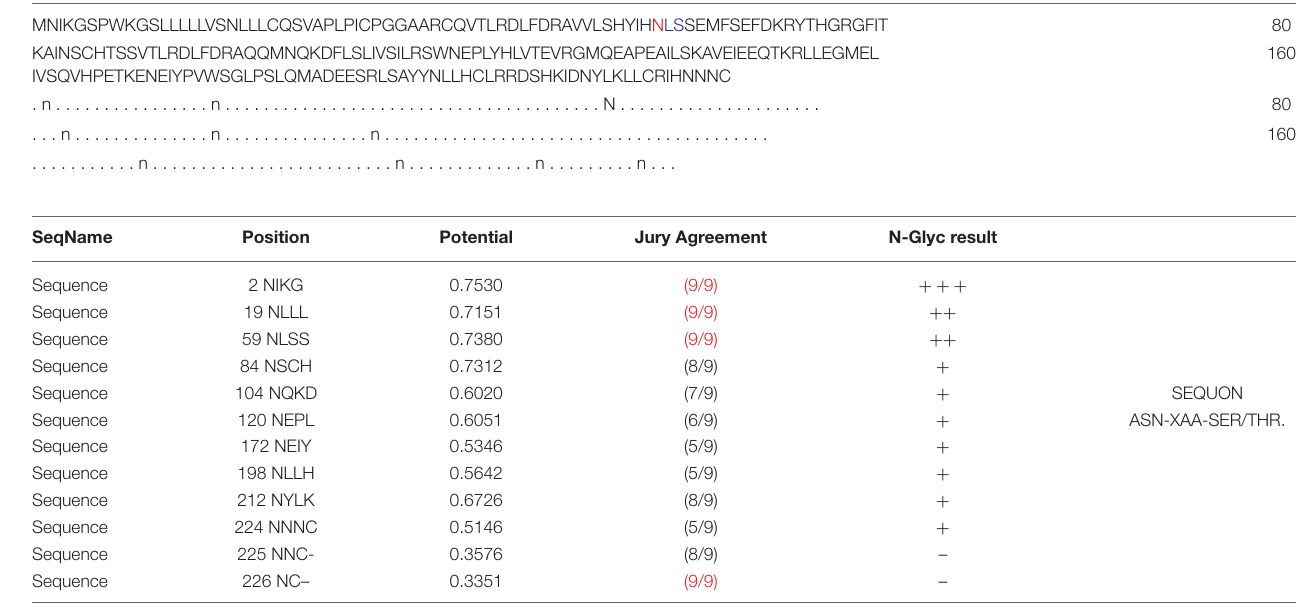
TABLE 7 | Prediction of N-glycosylation sites in hPRL (position 1–227) with NetNGlyc 1.0 Server with score more than 0.5.